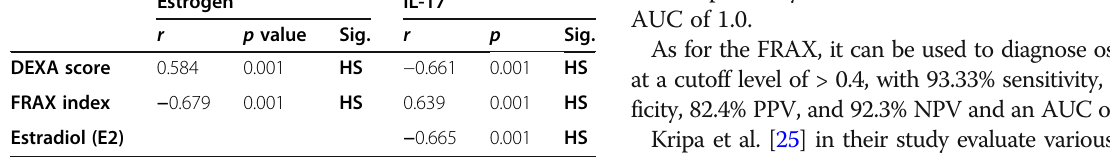
Table 5 Correlation study between IL-17, E2, and radiological data in postmenopausal women Estrogen IL-17 p value Sig.